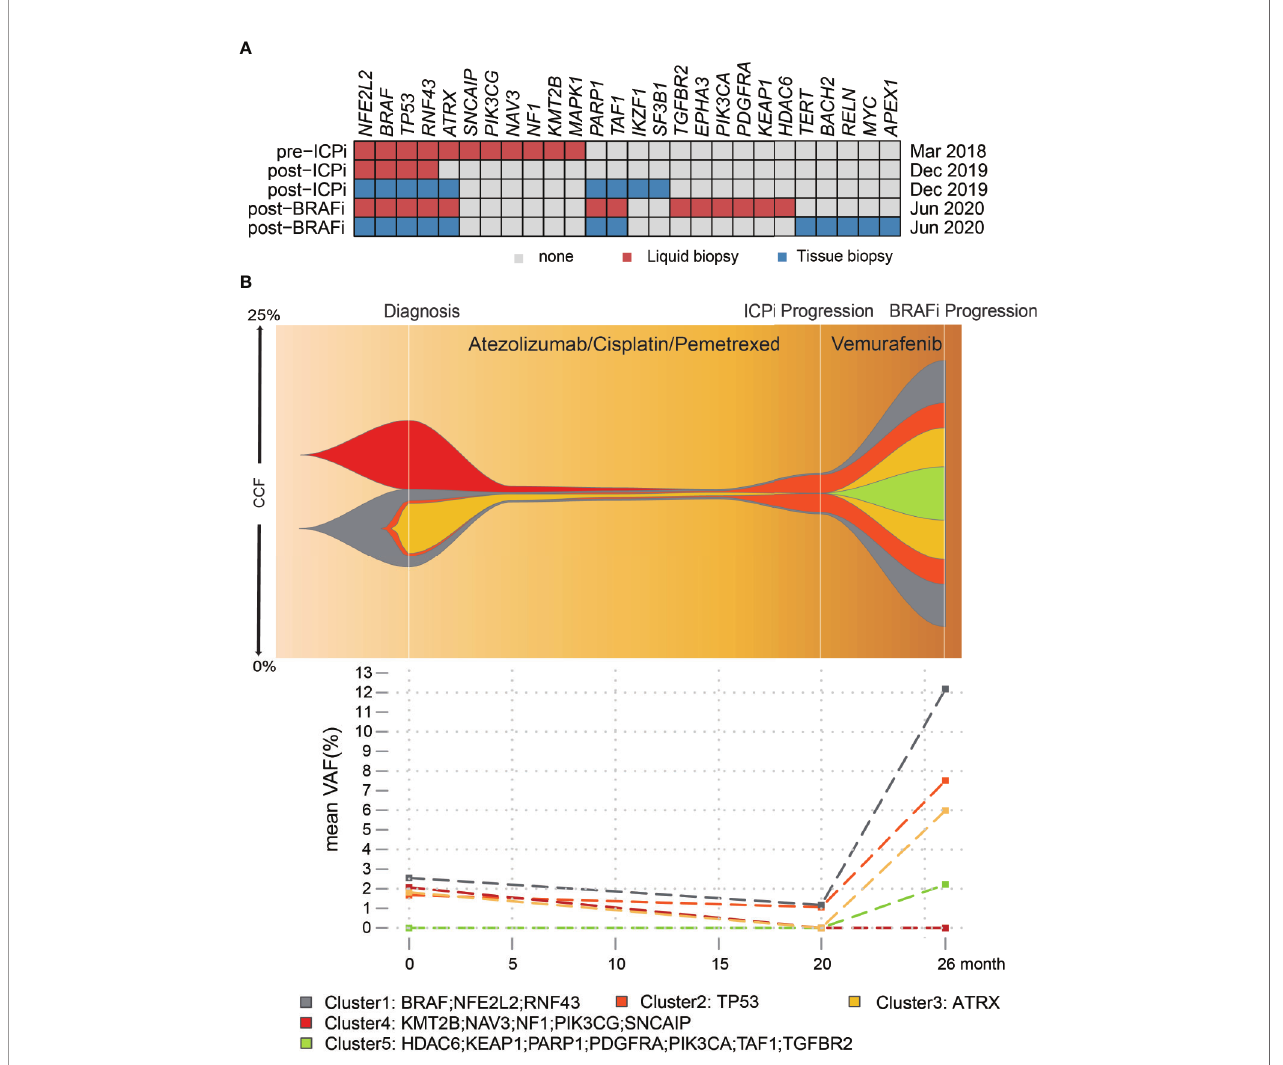
FIGURE 3 | Somatic mutation pro fi les of pre-ICPi, post-ICPi/pre-BRAFi, and post-BRAFi. (A) The heatmap shows an overview of mutations in pre-ICPi, post-ICPi/ pre-BRAFi, and post-BRAFi within liquid biopsy, pericardial effusion biopsy, and left supraclavicular lymph node. (B) Clonal evolution in liquid biopsy dynamic monitoring (Upper) and mean variant allele frequency (VAF) change (Lower) during immunotherapy and BRAF inhibitor Vemurafenib treatment. Variants from cfDNA using Bayesian cluster with PyClone. CCF, cancer cell fraction; ICPi, immune check-point inhibitor; BRAFi, BRAF